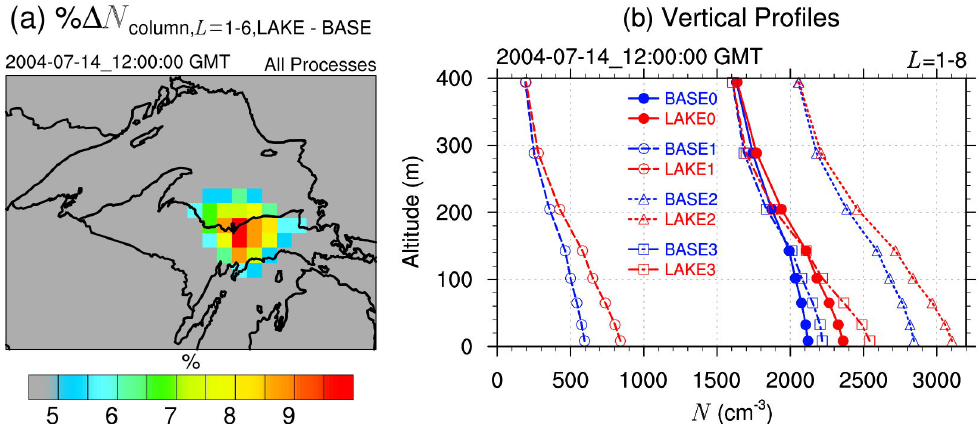
Fig. 6. Results at 12:00:00GMT on 14 July 2004: (a) percent difference in column aerosol number burden summed over the lowest six model layers between the LAKE0 and BASE0 cases when all aerosol dynamical processes are included in the model; (b) vertical profiles of aerosol number for the lowest eight model layers and for the grid cells highlighted in (a)